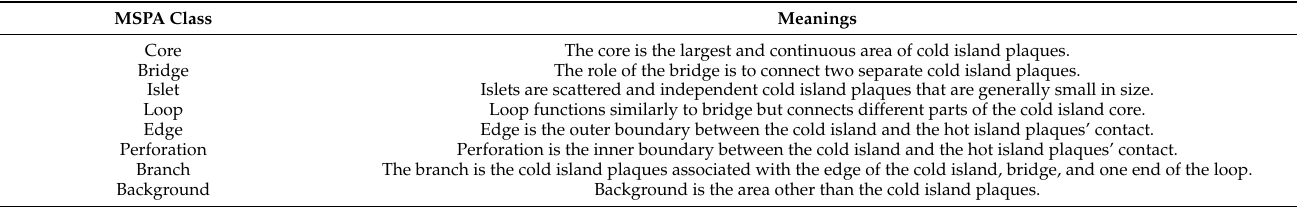
Table 4. MSPA Classification